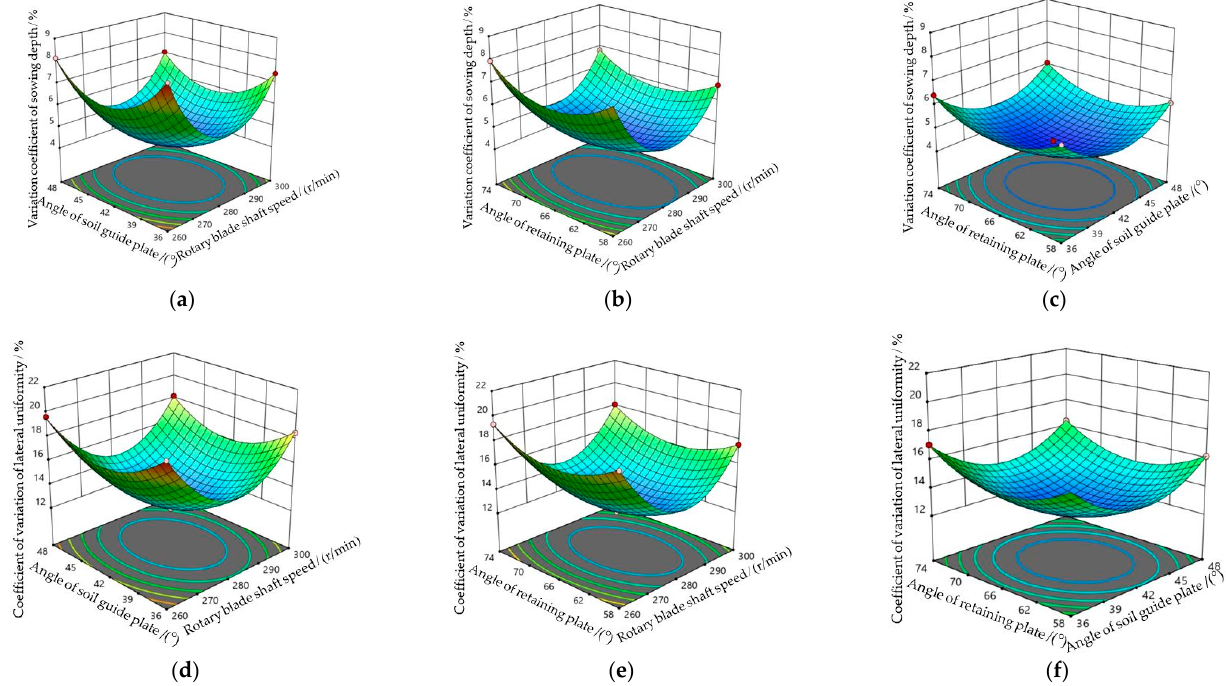
Figure 12. Response surface of interaction factors to the variation coefficient of sowing depth and variation coefficient of lateral uniformity. ( a ) Response of rotating blade shaft speed and angle of soil guide plate to sowing depth coefficient; ( b ) Response of angle of soil guide plate and angle of retaining plate to sowing depth coefficient; ( c ) Response of rotating blade shaft speed and angle of retaining plate to sowing depth coefficient; ( d ) Response of rotating blade shaft speed and angle of soil guide plate to lateral uniformity; ( e ) Response of angle of soil guide plate and angle of retaining plate to lateral uniformity; ( f ) Response of rotating blade shaft speed and angle of retaining plate to lateral uniformity.